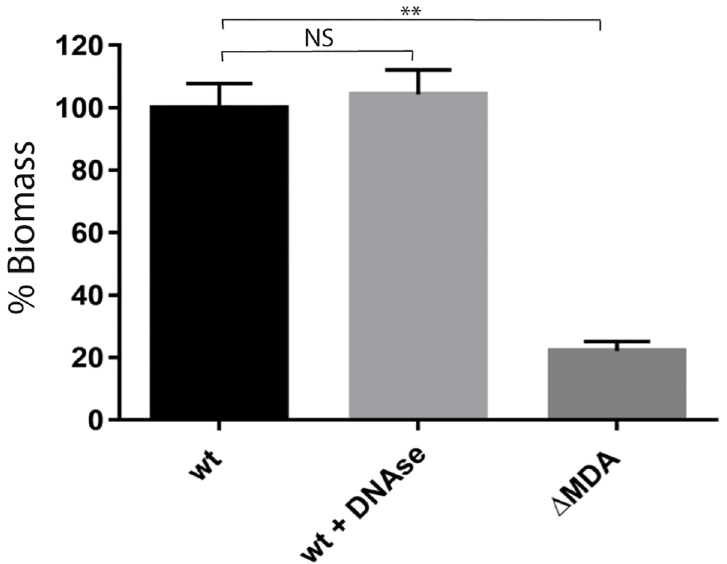
Fig 4. DNAseand formation of the biomass colonizing epithelial cells. Z5463 gfp and Z5463 gfp Δ MDA strains were grown in the presenceon FaDu epithelialcells for 18 hours under constant flow. To assess the potential role of extra cellularDNA (eDNA), experiments were carried in the presenceof DNAse at a concentration of 1 μ g/mL. At least three independentexperiments were performed. The results are normalized as a percentage of the mean biomass of the wild-typestrain, which was set to 100%. Error bars indicatethe standard errors of the mean (SEM). ** p < 0.0001 (One-way ANOVA), NS: not significant p value.